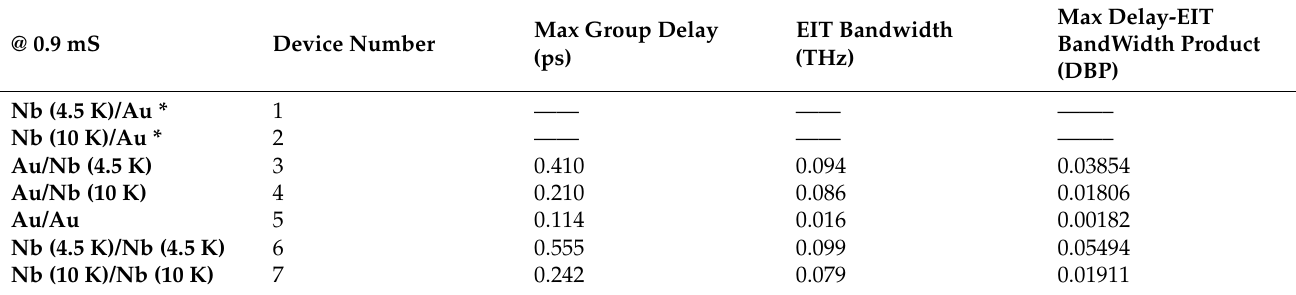
Table A2. Maximum group delay, EIT bandwidth, and maximum group delay-EIT bandwidth product (DBP) of different hybrid circuits at σ 0 = 0.9